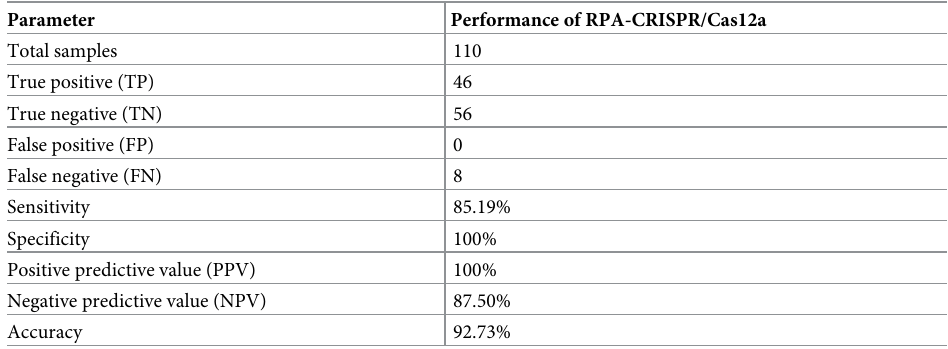
Table 2. Performance of the RPA-CRISPR/Cas12a-FBDA relative to qPCR